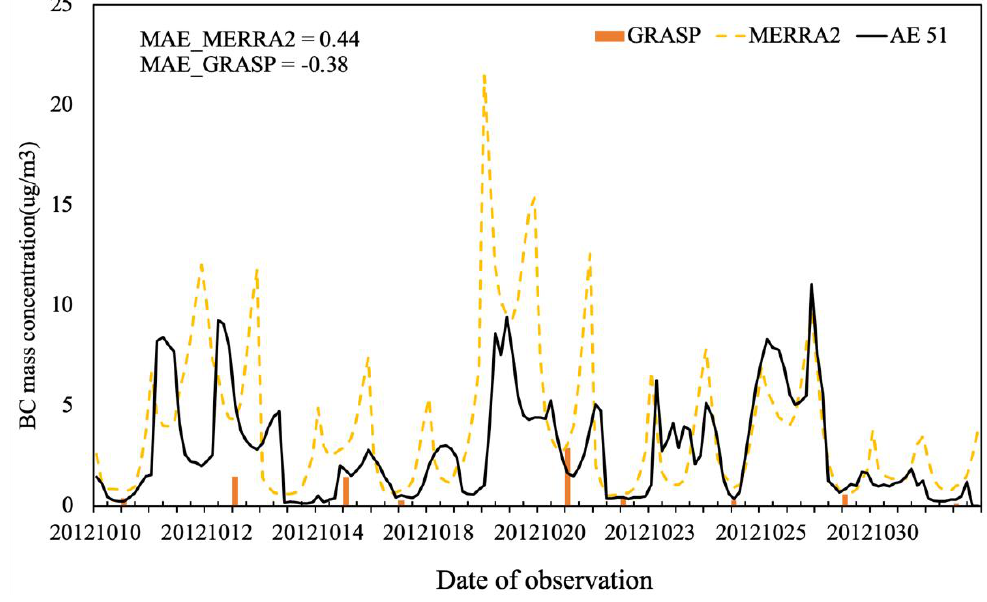
Figure 16. Evaluation of near surface BC mass concentration from MERRA-2 and PARASOL/GRASP with in situ measurements at